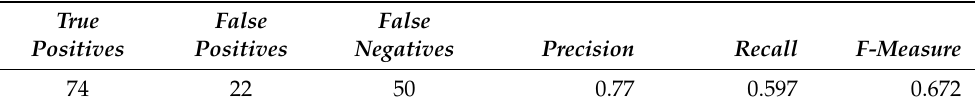
Table 2. Results of the application of the artefact to the Enron CEO’s sent folder.